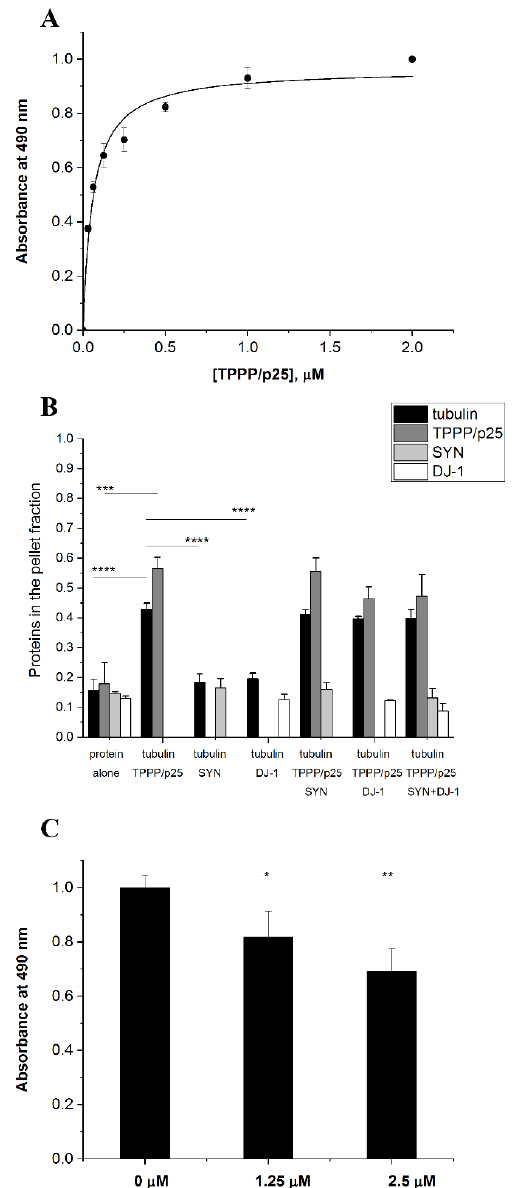
Figure 1. TPPP/p25 is an interacting partner of DJ-1. ( A ) Binding of TPPP/p25 to immobilized DJ-1 detected in an ELISA experiment. The K d was evaluated from the saturation curve by non-linear curve fitting (K d 58.1 ± 9.49 nM). ( B ) Effect of DJ-1 on the tubulin polymerization-promoting potency of TPPP/p25 using the pelleting experiment, as described in the Material and Methods. The partition of the proteins in the pellet (P) fraction was quantified by densitometric analysis (n = 3-4). ( C ) Inhibitory effect of TPPP/p25 on the interaction of -SYN with DJ-1 obtained by a competitive ELISA experiment. Data were normalized with respect to SYN without TPPP/p25 (n = 4). ( A – C ) Data are presented as the mean ± SD. Statistical comparisons were performed with one- way ANOVA followed by Tukey’s test, as compared to the control or as the lines indicate (* p < 0.05, ** p < 0.01, *** p < 0.001 and **** p < 0.0001). TPPP/p25 promotes the tubulin polymerization into intact-like, double-walled mi- crotubules and aggregate, causing their bundling, which stabilizes the dynamic microtu- bule network, promoting resistance against anti-mitotic agents [12,37]. Then, the effect of